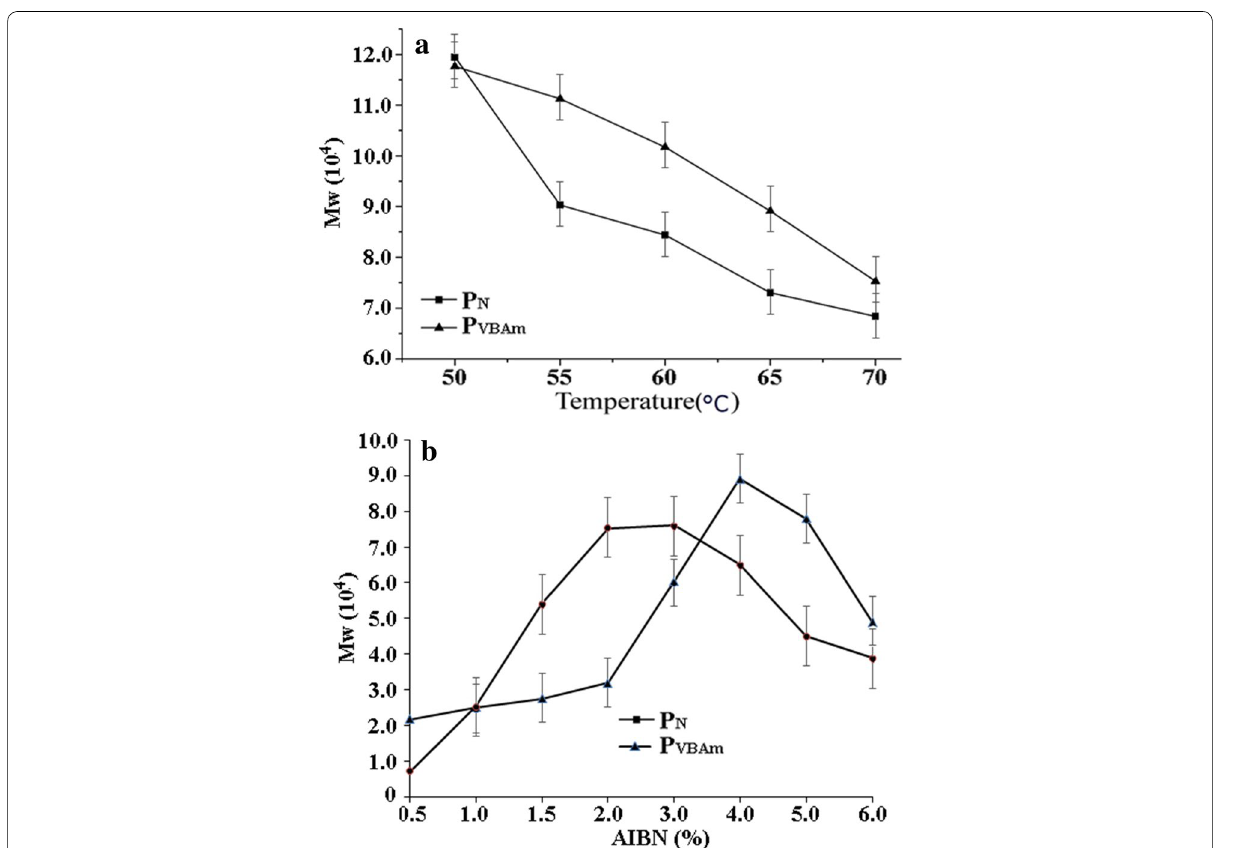
Fig. 2 Effect of a temperature and b concentration of AIBN on M v of P VBAm and P N ; The polymerization reaction was carried out for 24 h at a shaking speed of 120 rpm. P VBAm was polymerized with an NVCL/BMA/Am monomer ratio: 5:0.5:0.2. M v was measured at 25 °C. In a 4% (w/w) AIBN was used as the initiator; in b the reaction was carried out at 65